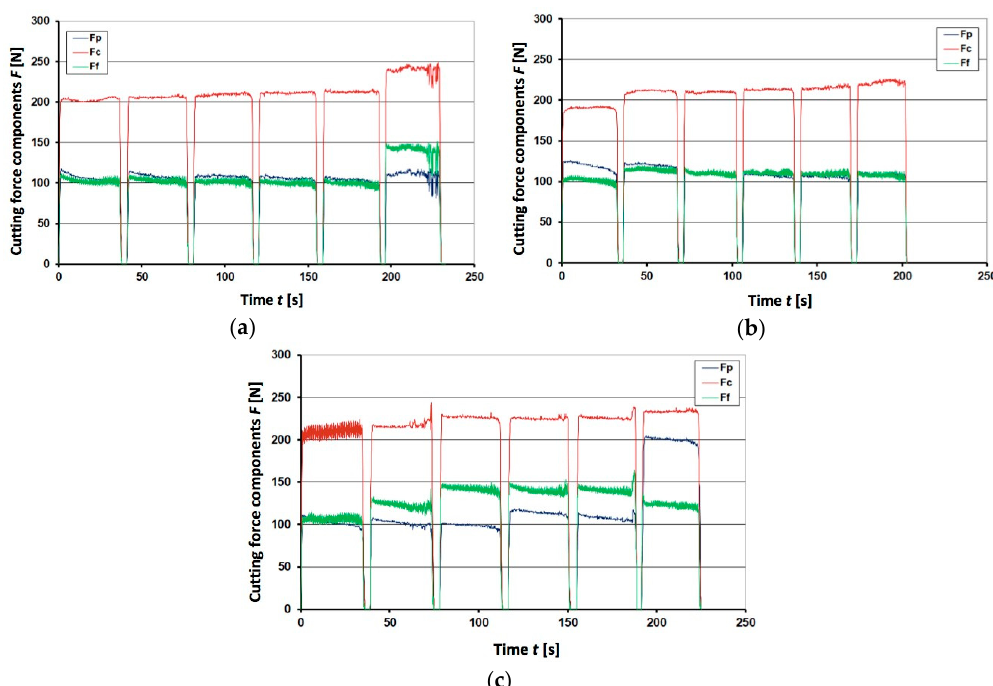
Figure 7. Registered force components F p , F c , and F f for the Y + implanted at dose 2 × 10 17 ion/cm 2 insert IS9: ( a ) 1st edge; ( b ) 2nd edge; ( c ) 3rd edge.